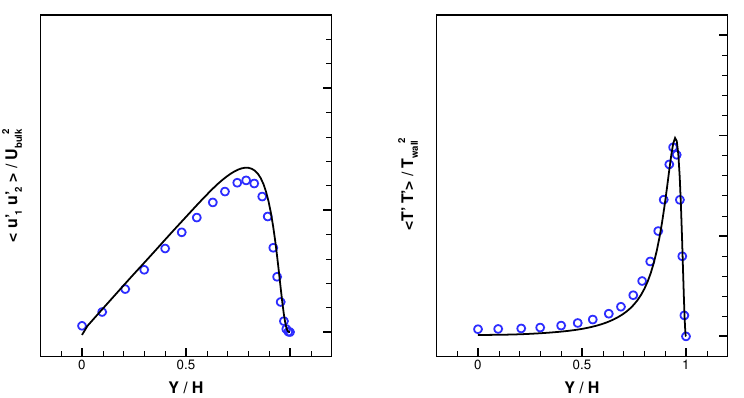
Figure 3. WA-LES of supersonic channel flow: profiles of turbulent shear stress and mean square temperature fluctuation, compared to reference DNS